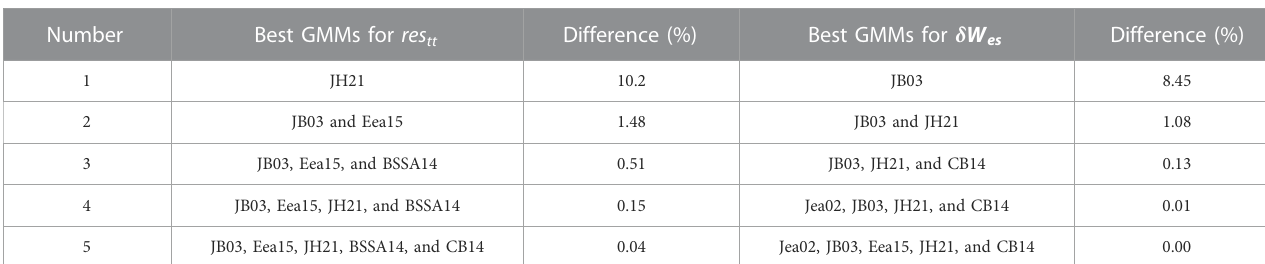
TABLE 4 Best GMMs for different numbers of candidates.